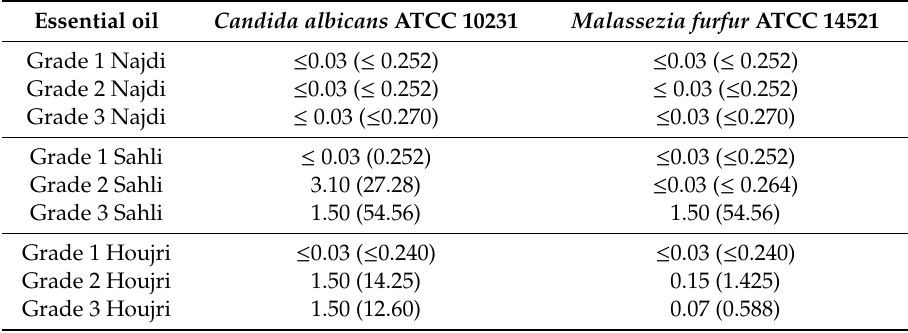
Table 4. Antifungal activity MIC values in % v / v and in mg / mL between